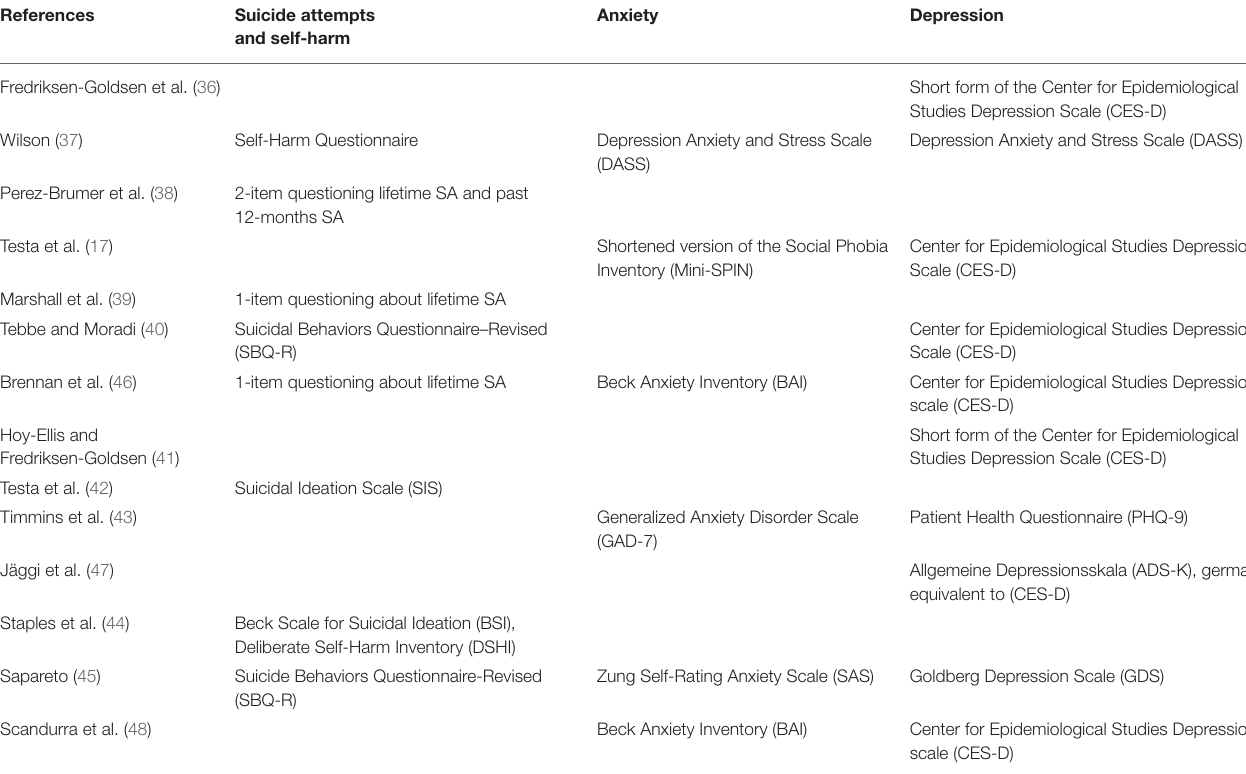
TABLE 6 | Description of studies’ instruments to assess mental